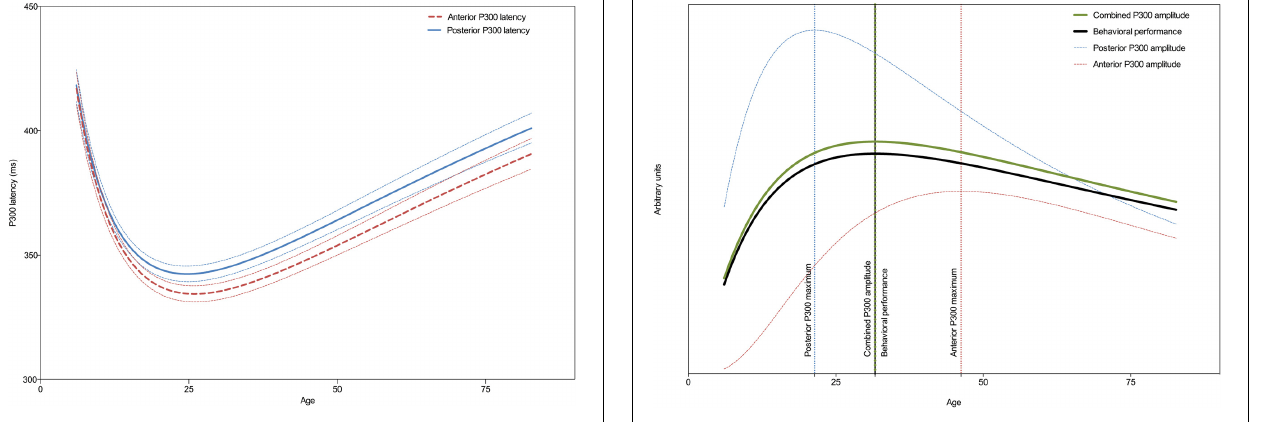
FIGURE 4 | Developmental trajectories of behavioral performance, the frontal (Fz), the parietal (Pz), and the combined P300 amplitude across the lifespan. Vertical lines indicate points of deflection in these trajectories. Behavioral performance is plotted on an inverted y scale. Note the similarity between the developmental trajectories of the combined P300 amplitude and behavioral performance, suggesting that behavioral performance is best associated with frontal and parietal